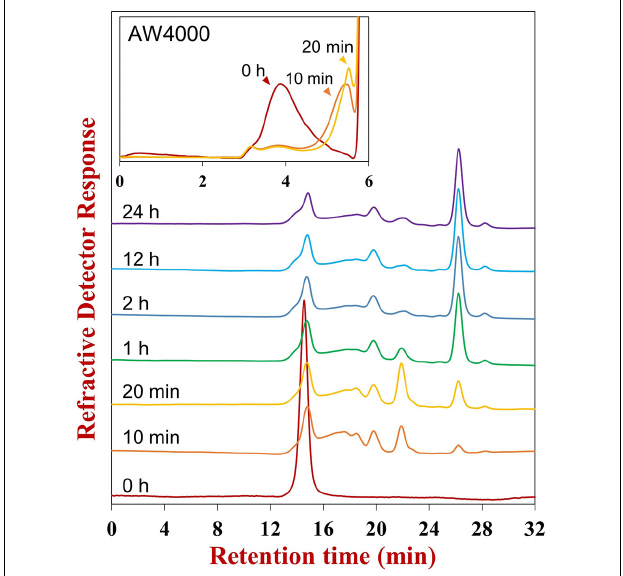
FIGURE 1 | HPSEC-RID chromatograms of hydrolysis products obtained at different reaction times. The reaction time was labeled above the corresponding chromatogram. After 12 h reaction, the fresh enzyme was supplemented into the reaction mixture and incubated for a further 12 h to prepare the end product (24 h). The Superdex peptide 10/300 GL column was employed for examining the oligosaccharide pattern, and the TSKgel SuperAW4000 column was utilized for investigating the global profile (the